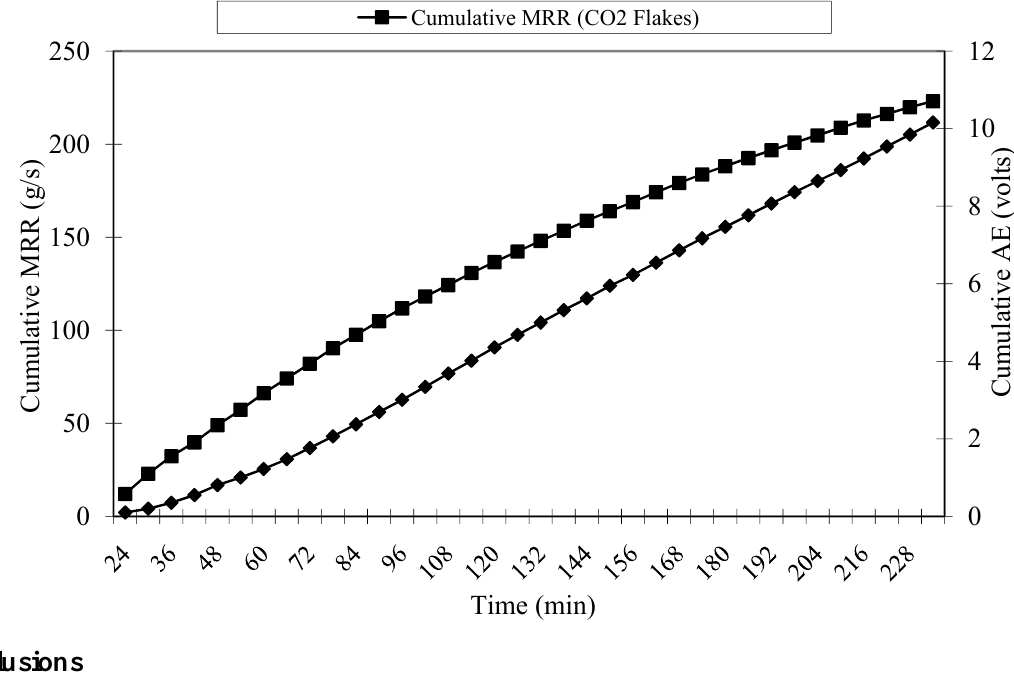
Figure 6. Cumulative material removal rate and cumulative contact resonant AE signal after cleaning with CO flakes during abrasive 2